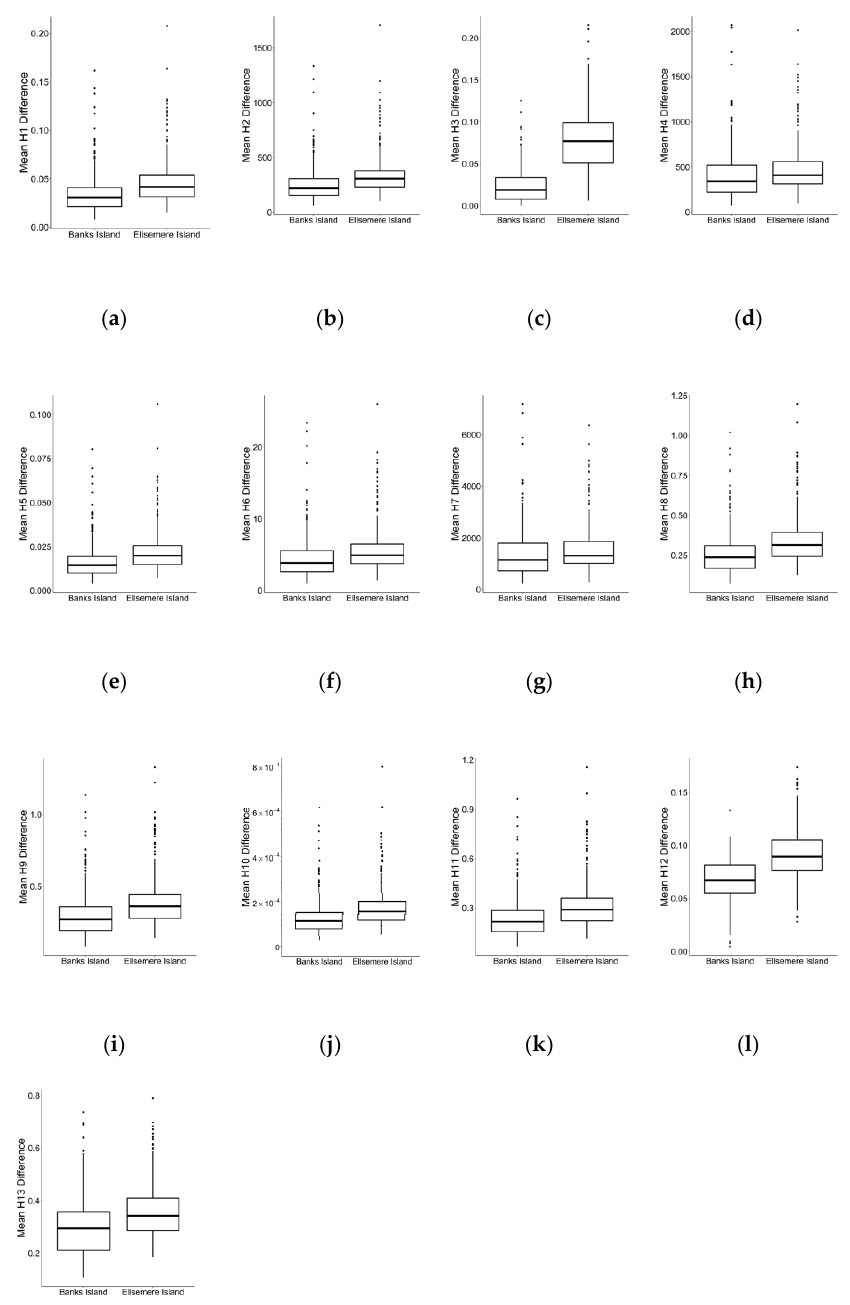
Figure 7. Boxplots ( a – m ) showing Haralik texture feature comparisons of hand-annotated RTS from the Eureka Sound Lowlands and Banks Island. ( a ) H1(Angular second moment). ( b ) H2 (Contrast). ( c ) H3 (Correlation). ( d ) H4 (Variance). ( e ) H5 (Inverse difference moment). ( f ) H6 (Sum Average).